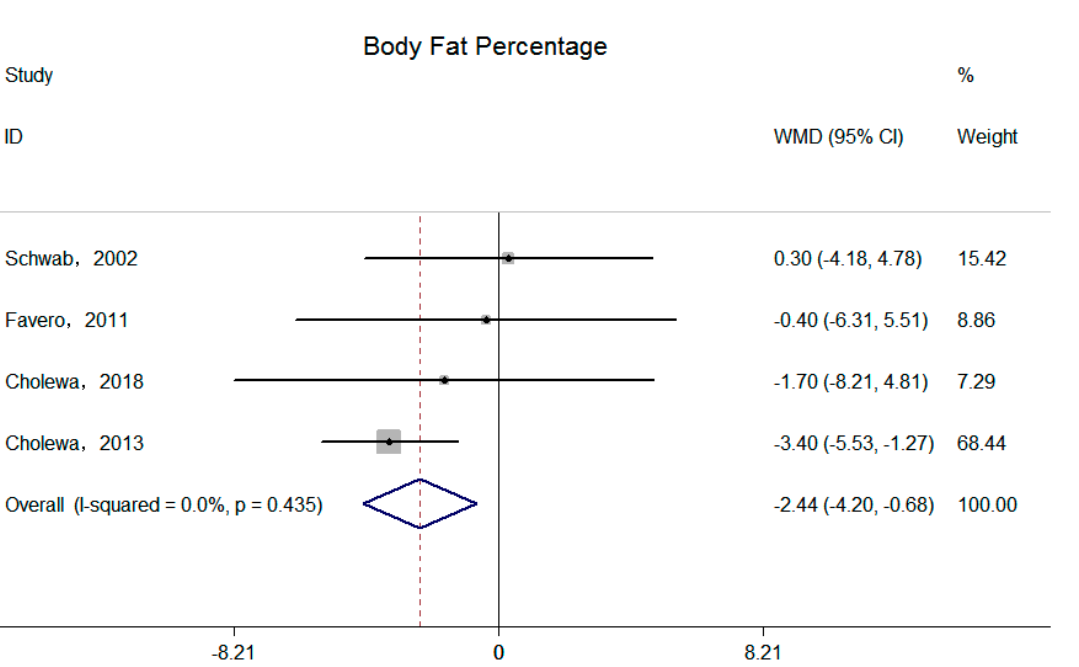
Figure 4. Effects of supplemental betaine on total body fat mass in participants. The pooled effect was calculated by using a random-effects model. The diamonds denote the summary risk estimate, and the horizontal lines represent the 95% CI.